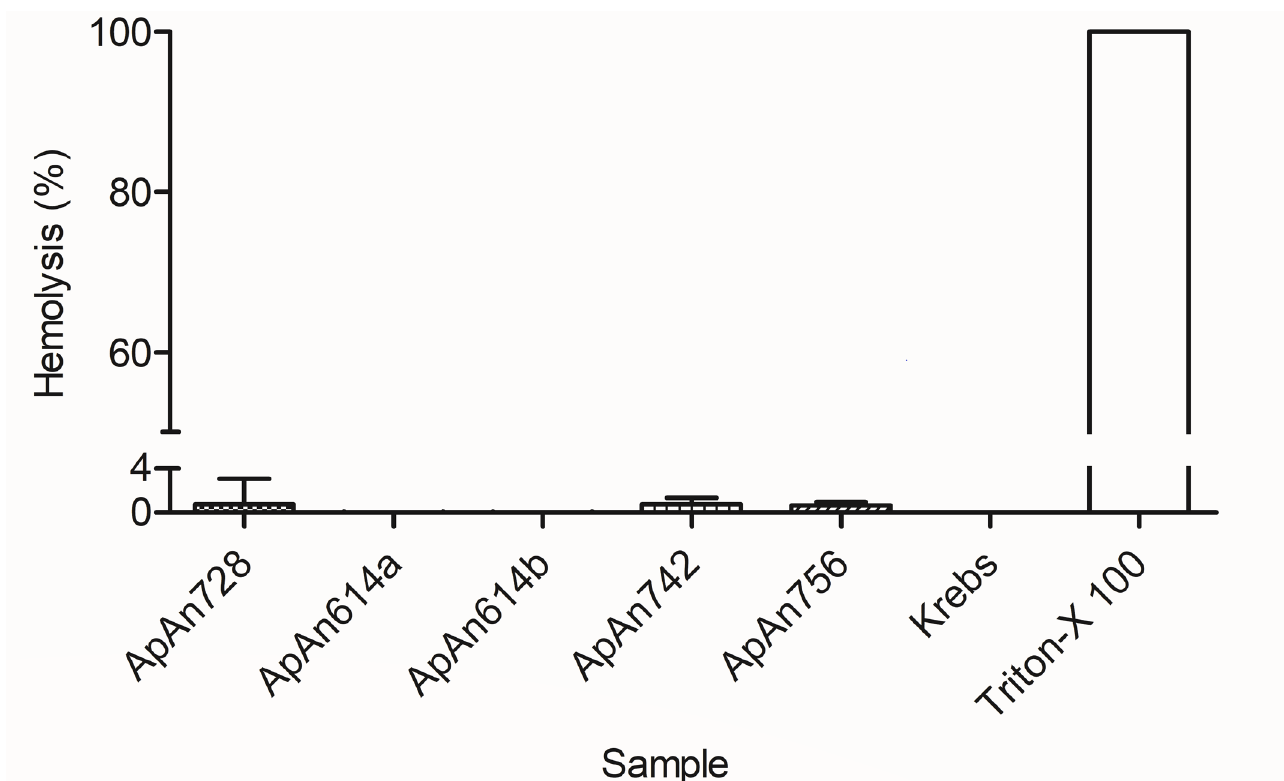
Figure 8. Hemolytic activity of ApAn728, ApAn614a, ApAn614b, ApAn742 and ApAn756. Krebs: buffer used as a 0% hemolysis control. Triton-X 100: used as a 100% hemolysis control. The graph represents the results obtained for the highest concentration used (256 µM). Data were expressed as mean ±